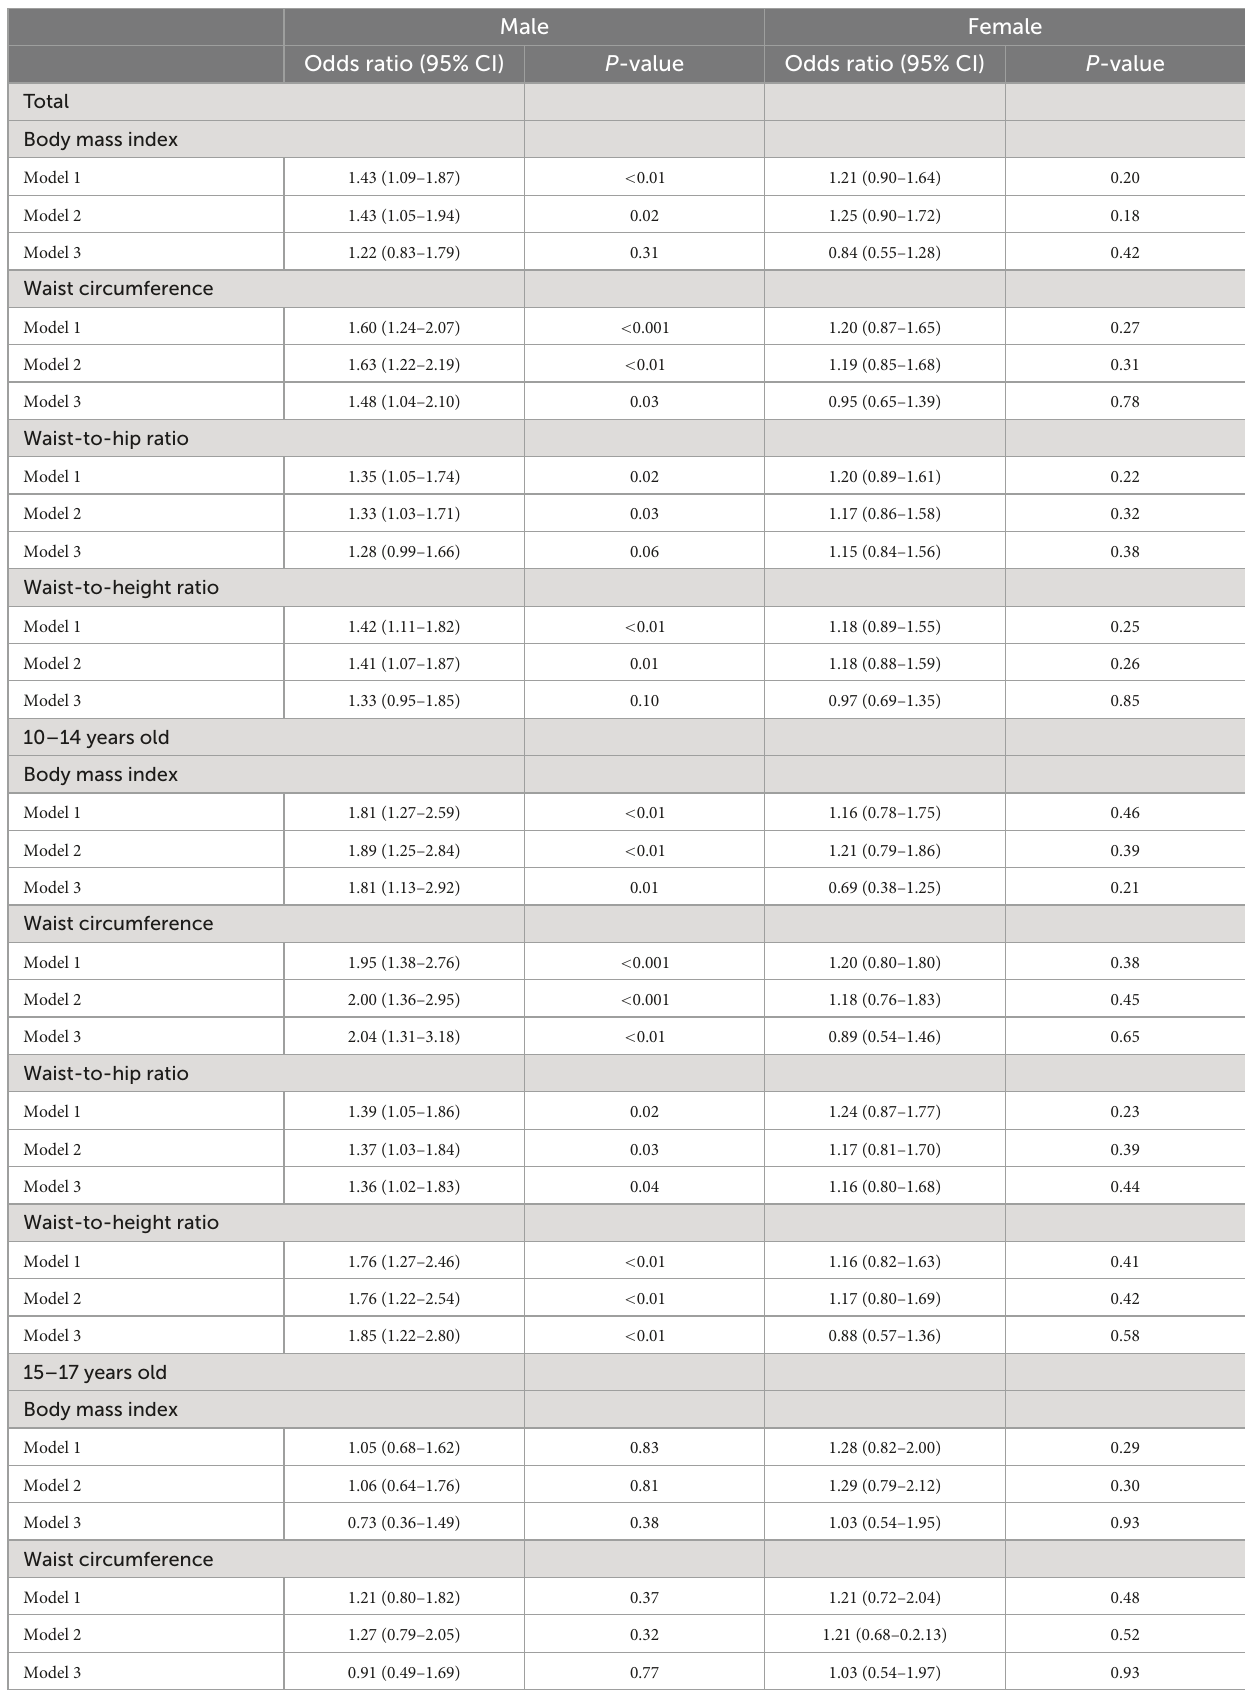
TABLE 2 Sex and age group stratified association of adolescent anthropometric indices with high carotid intima-media thickness ( ≥ 90th percentiles) in early